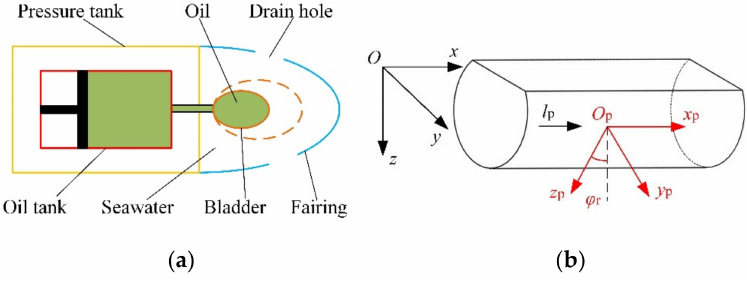
Figure 3. Buoyancy control device ( a ) and attitude control device ( b